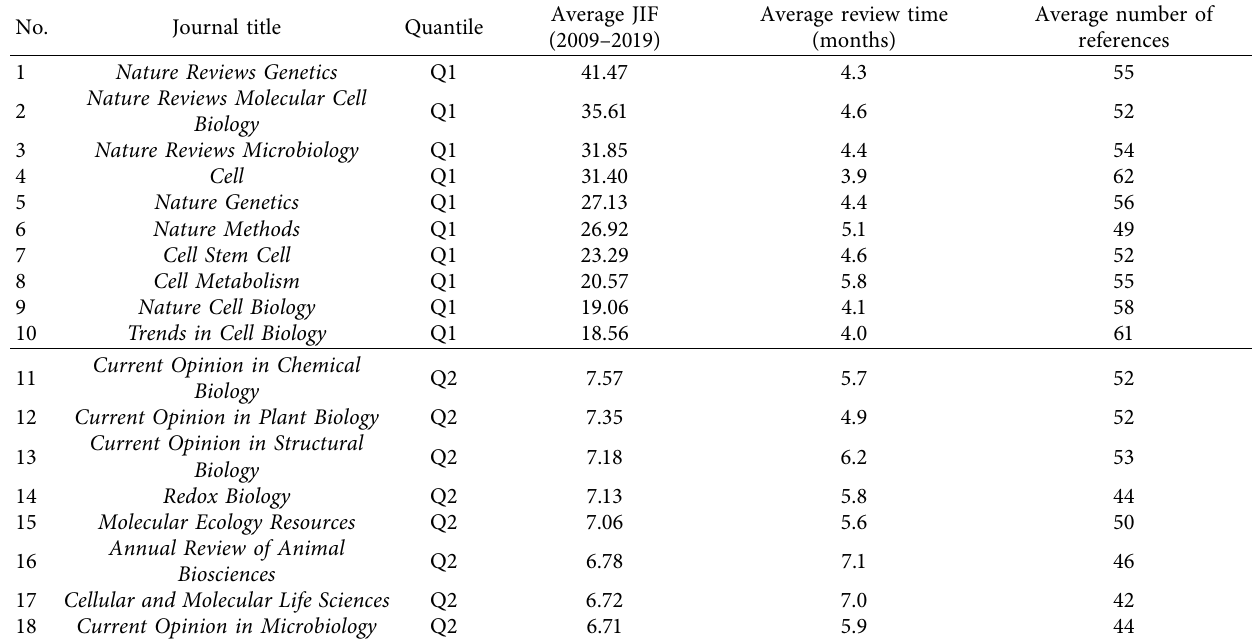
Figure 14: Comparison of average JIF, average review time ( T ), and average number of references ( N ) in Q1–Q4 for the 120 journals belonging to biology, AI, and mathematics. (a) Histogram of different indicators in Q1–Q4. (b) Comparison of average review time ( T ) and average number of references ( N ). (c) Comparison of average review time ( T ) and impact factors. (d) Comparison of average number of references ( N ) and impact factors. Table 3: Average JIF, average review time, and average number of references for 40 biology